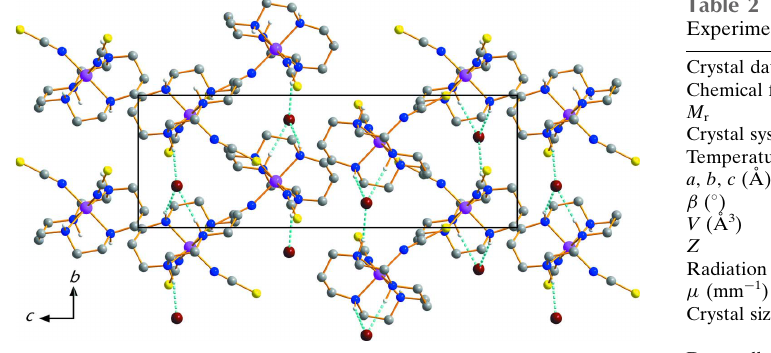
Figure 2 The crystal packing in (I), viewed perpendicular to the bc plane. Dashed lines represent N—H (cid:3)(cid:3)(cid:3) Br hydrogen-bonding interactions. For clarity, N—H (cid:3)(cid:3)(cid:3) S hydrogen-bonding interactions and H atoms bonded to C atoms have been